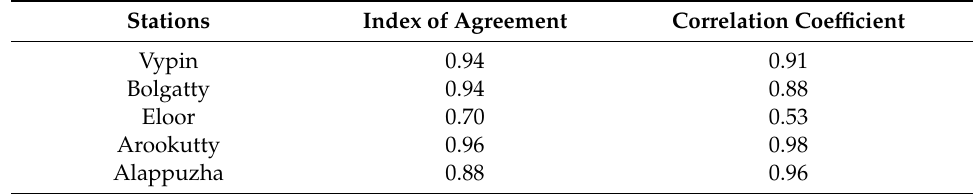
Figure 8. Normalized Taylor diagram for the statistical significance of surface salinity at 6 locations from 2013 to 2014. Table 4. Index values and correlations of the predicted / simulated daily surface salinity at six locations in CE from 2013 to